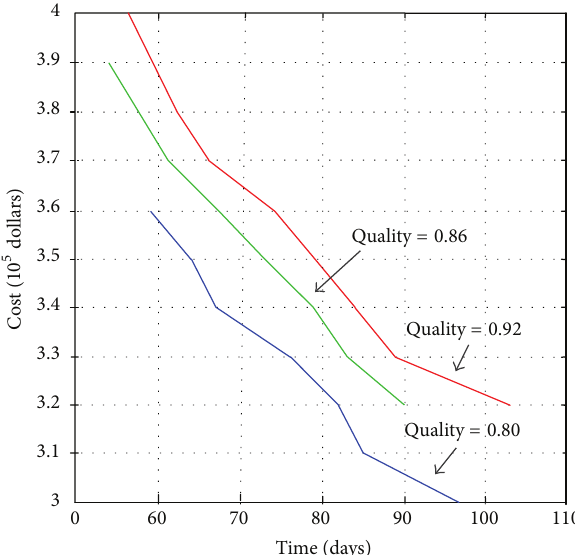
Figure 7: Tradeoff relationship between construction cost and time when the quality sets 0.80, 0.86, and